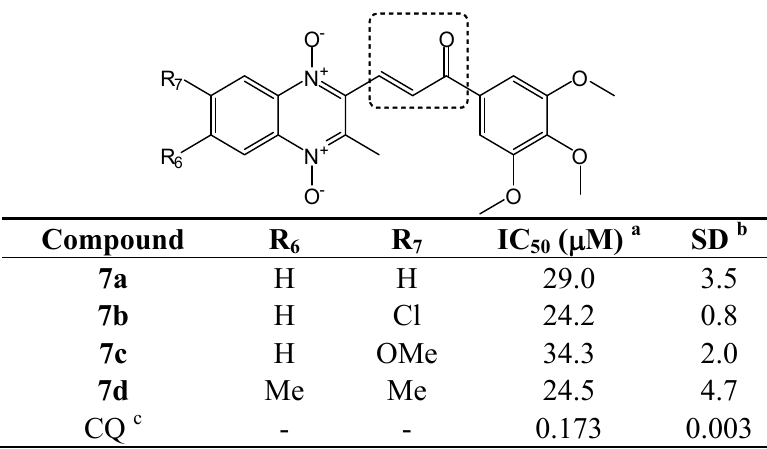
Table 3. In vitro activities of inverted chalcone